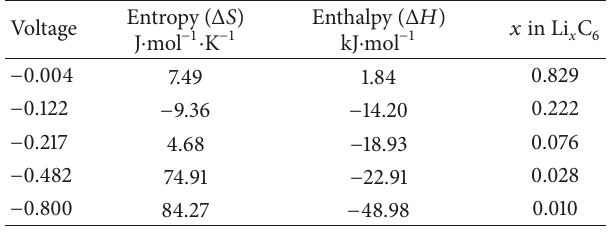
Table 2: Entropy and enthalpy data for graphite at 296 ∘ K.